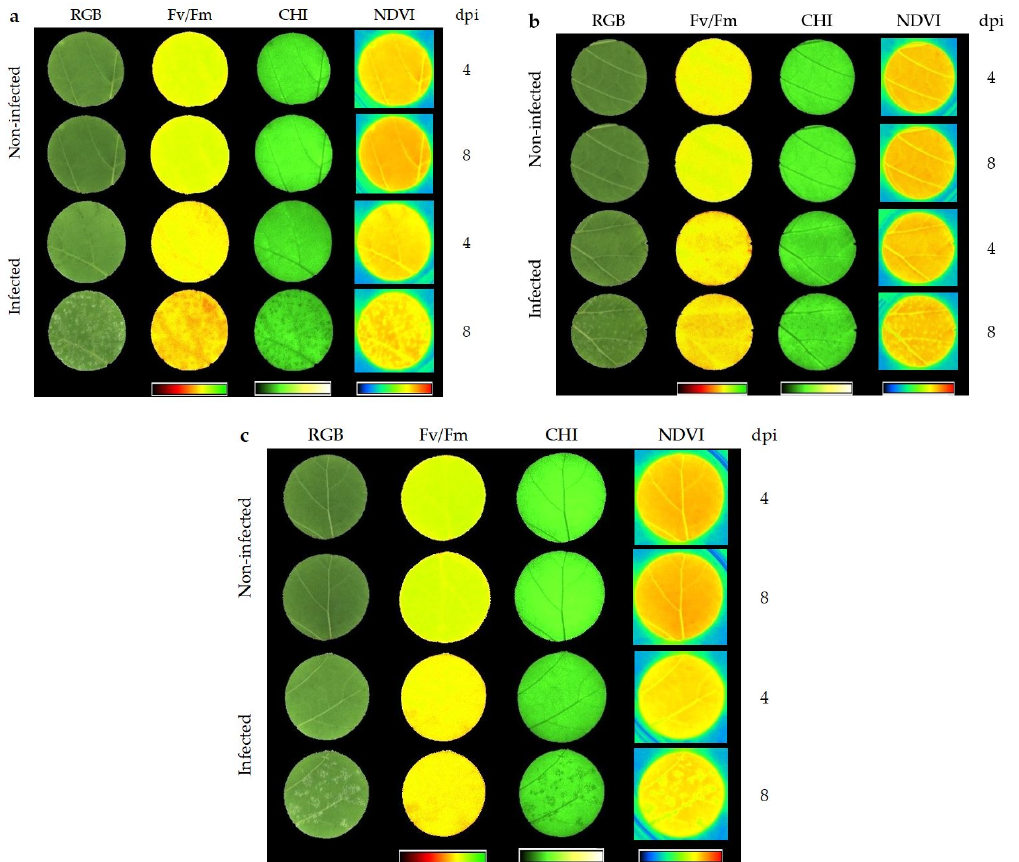
Figure 3. RGB (visual impression), F v /F m , chlorophyll index (CHI), and normalised difference vegetation index (NDVI) images of ( a ) Lasina (OIV (International Organisation of Vine and Wine) 1), ( b ) Malvasija dubrova č ka (OIV 3), and ( c ) Malvazija istarska (OIV 5) taken at four (T 4 ) and eight (T 6 ) dpi.